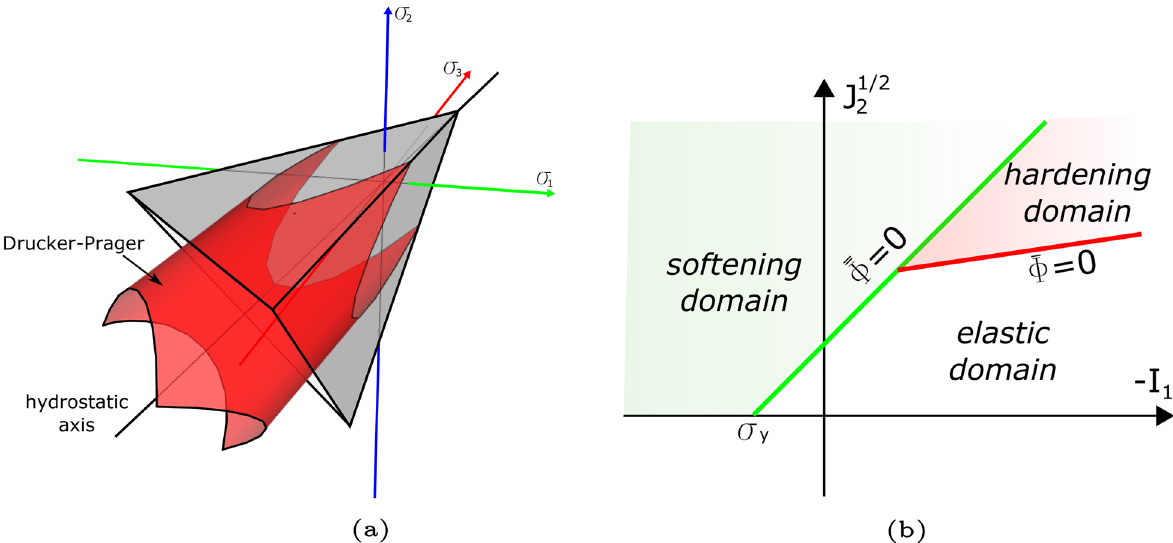
Fig. 16 Multi-surface macro-scale plasticity criterion combining Drucker–Prager (red cylinder) and St. Venant (gray wedge) that can capture both hardening and softening: a illustration in principal stress space; b cut in meridian